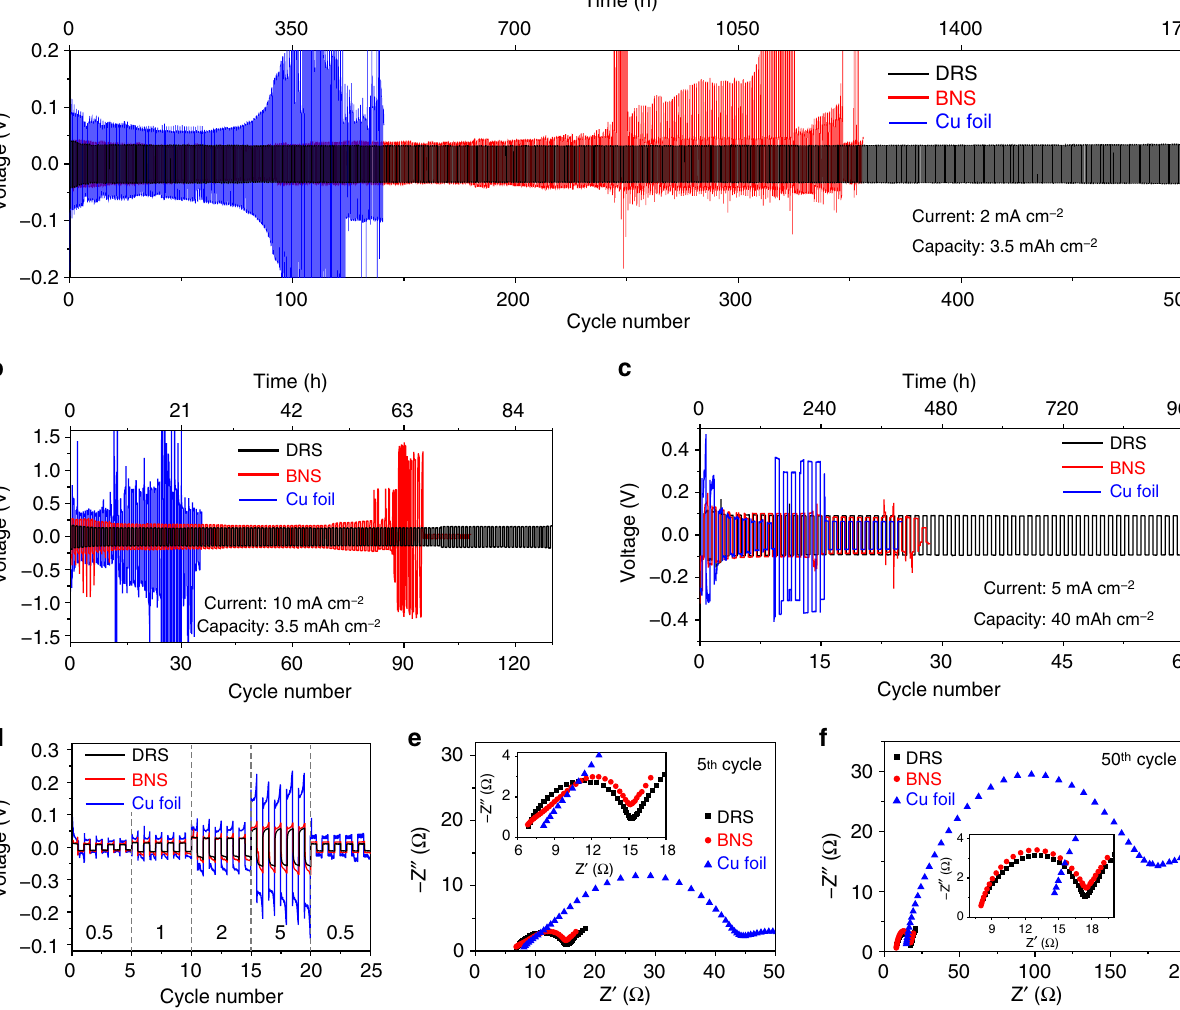
inset of Fig. 5g. There are still no dips below 0 V on the voltage curves, indicating that the overpotential for nucleation at 5 °C and − 15 °C is nearly the same as that at room temperature. Figure 5h